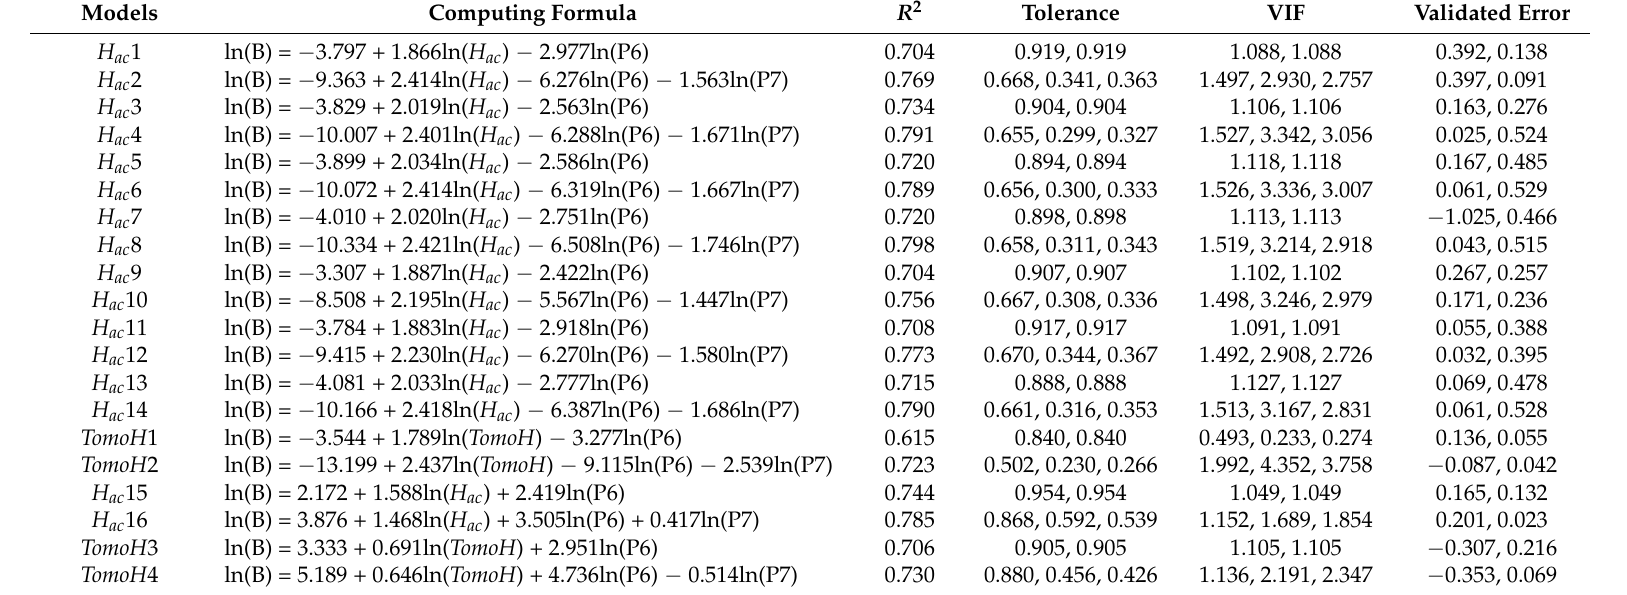
Table 4. Models for forest AGB